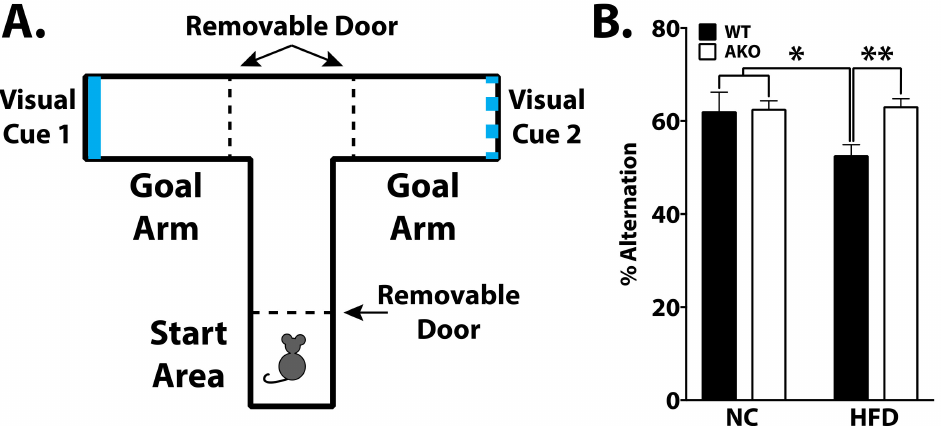
Figure 4. Loss of FABP4 rescues HFD-induced working reference memory decline. ( A ). Representa- tion of T-maze apparatus to measure spatial working reference memory. Mice were placed in start arm and allowed free choice to either goal arm. Once body fully in arm, removable partition was closed allowing mice to stay in goal arm for 15 s and then placed back in start area. Mice underwent an additional 10 trials per day for a total of 2 days. Percent alternation was calculated as the number of spontaneous alternations (choosing the novel arm, unexplored from the previous trial) divided by the maximum number of alternations. ( B ) WT mice fed HFD have reduced alternations over all trials (* p < 0.05 vs. WT-NC and AKO-NC, ** p < 0.01 vs. AKO-HFD). Data analyzed via one-way ANOVA and Tukey’s